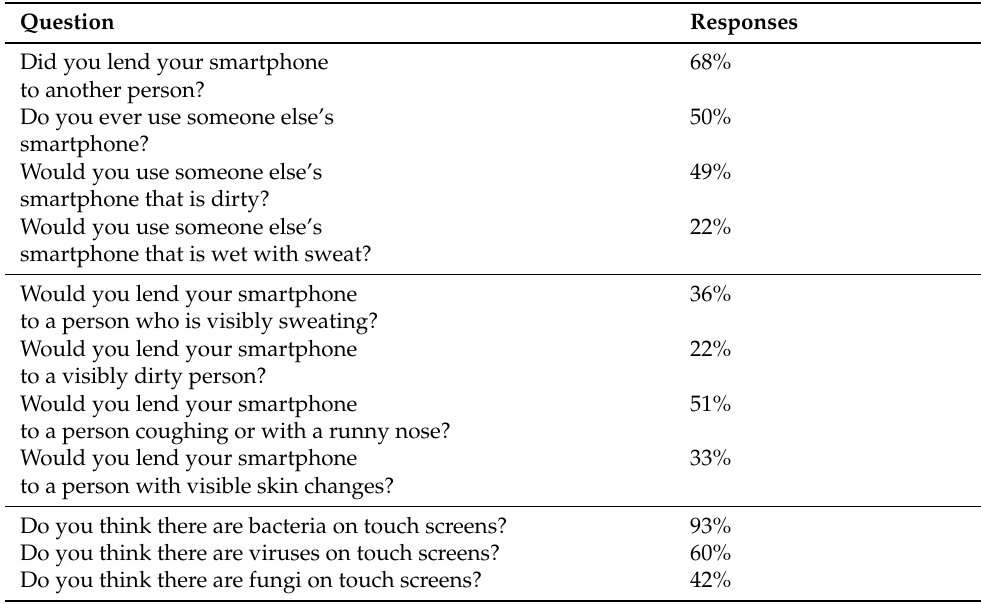
Table 5. Responses for 50%